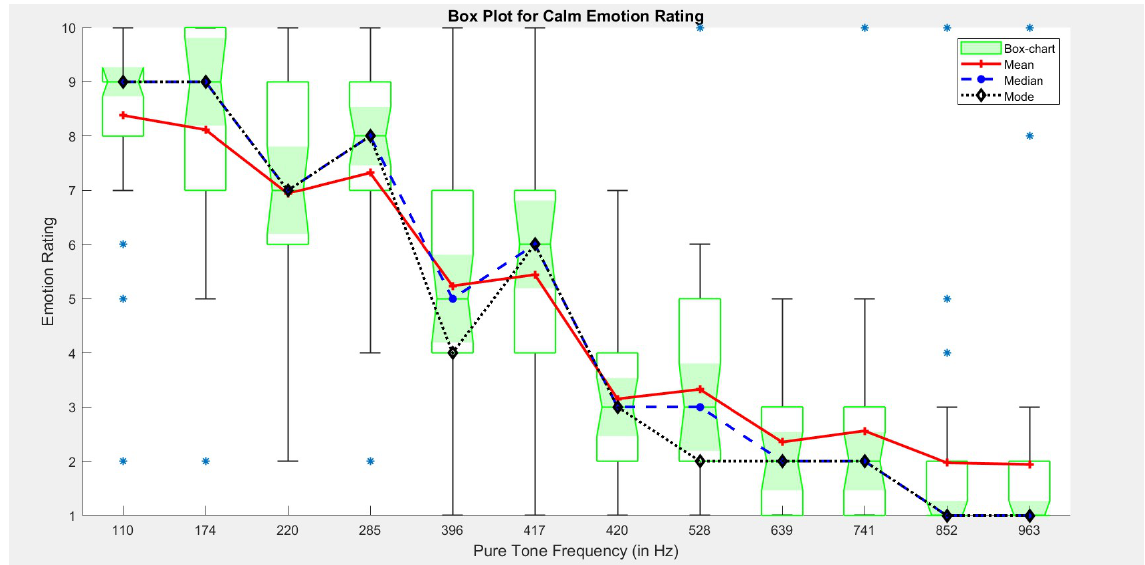
Figure 5. Plot for Calm emotion rating v/s Pure tone frequency. Here, the shaded area (green in color) of box chart represents distribution for annotated emotion corresponding to each pure tone